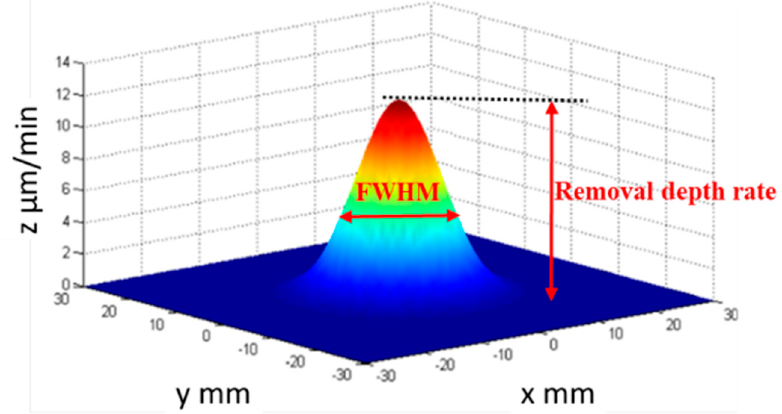
Figure 2. Gaussian shape removal function of APPP.